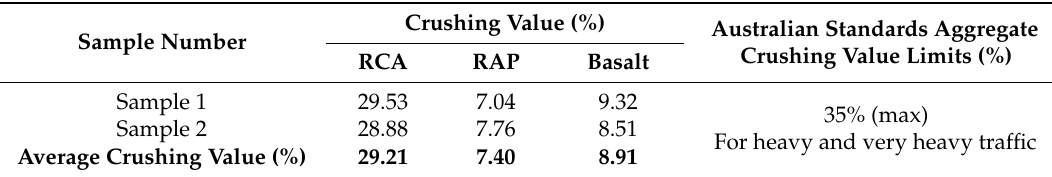
Table 6. The Results of Aggregate Crushing Value Test for Coarse Aggregates and Crushing Value Limits for Dense Graded Asphalt Based on Australian